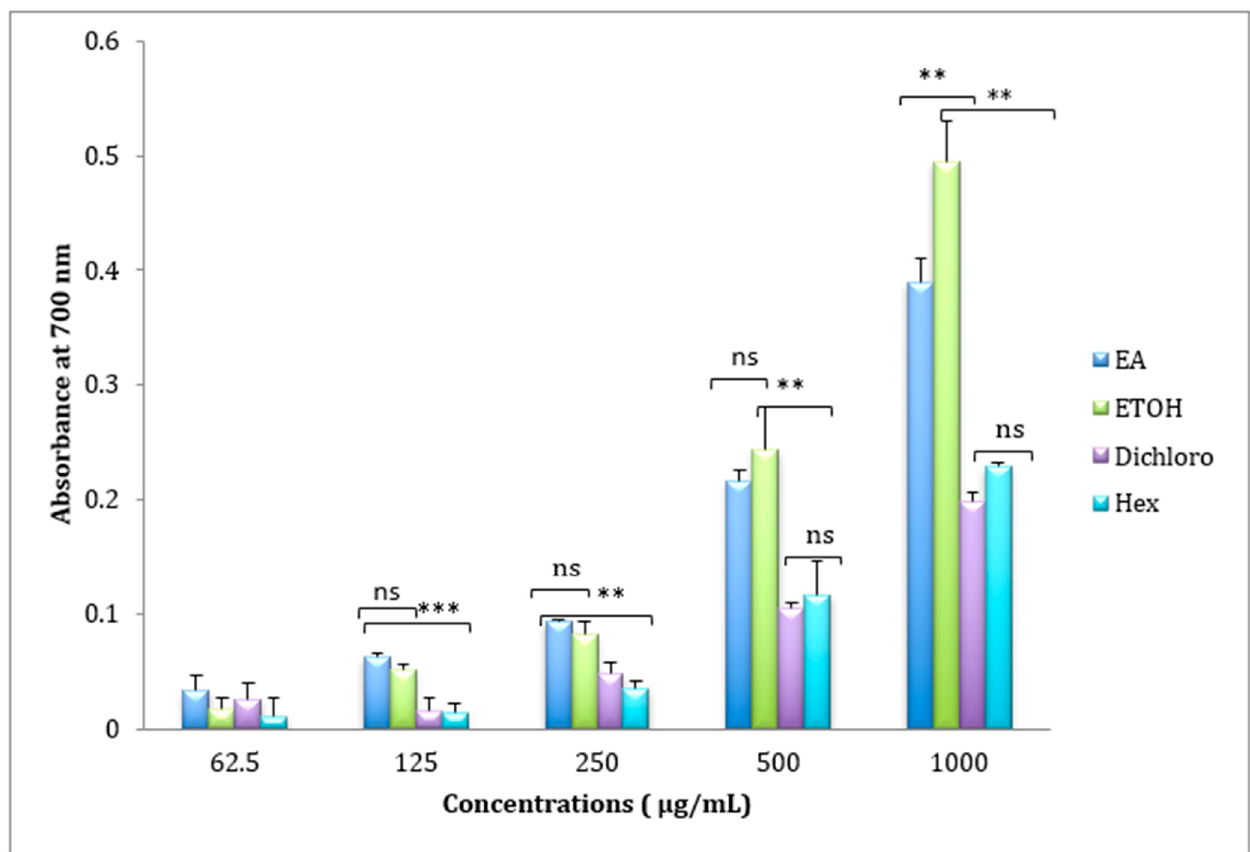
Figure 3. Reducing power of Ethyl Acetate (E.A), Ethanolic (ETOH), Dichloromethane (Dichloro), and Hexanic extracts of Cistus ladanifer (mean ± SD, n = 3 experiments, ns: not significant , p values; **: p < 0.01, *** p <